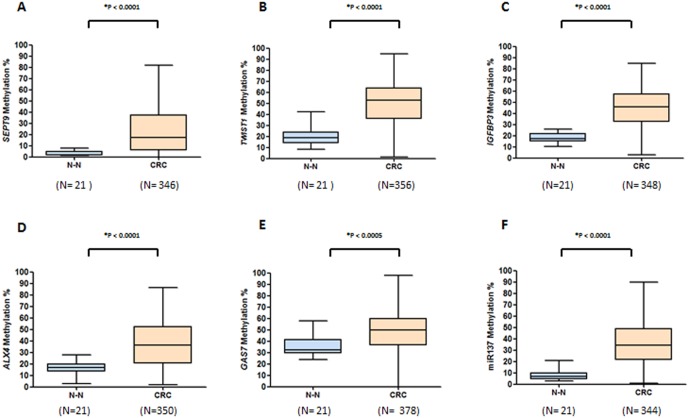
Comparison between levels of methylation in primary tumors vs. normal colonic mucosa.Bisulfite pyrosequencing results for methylation of SEPT9 (A), TWIST1 (B), IGFBP3 (C), ALX4 (D), GAS7 (E) and miR137 (F) genes comparing normal mucosa from healthy controls (N–N) and primary tumors from CRC patients.